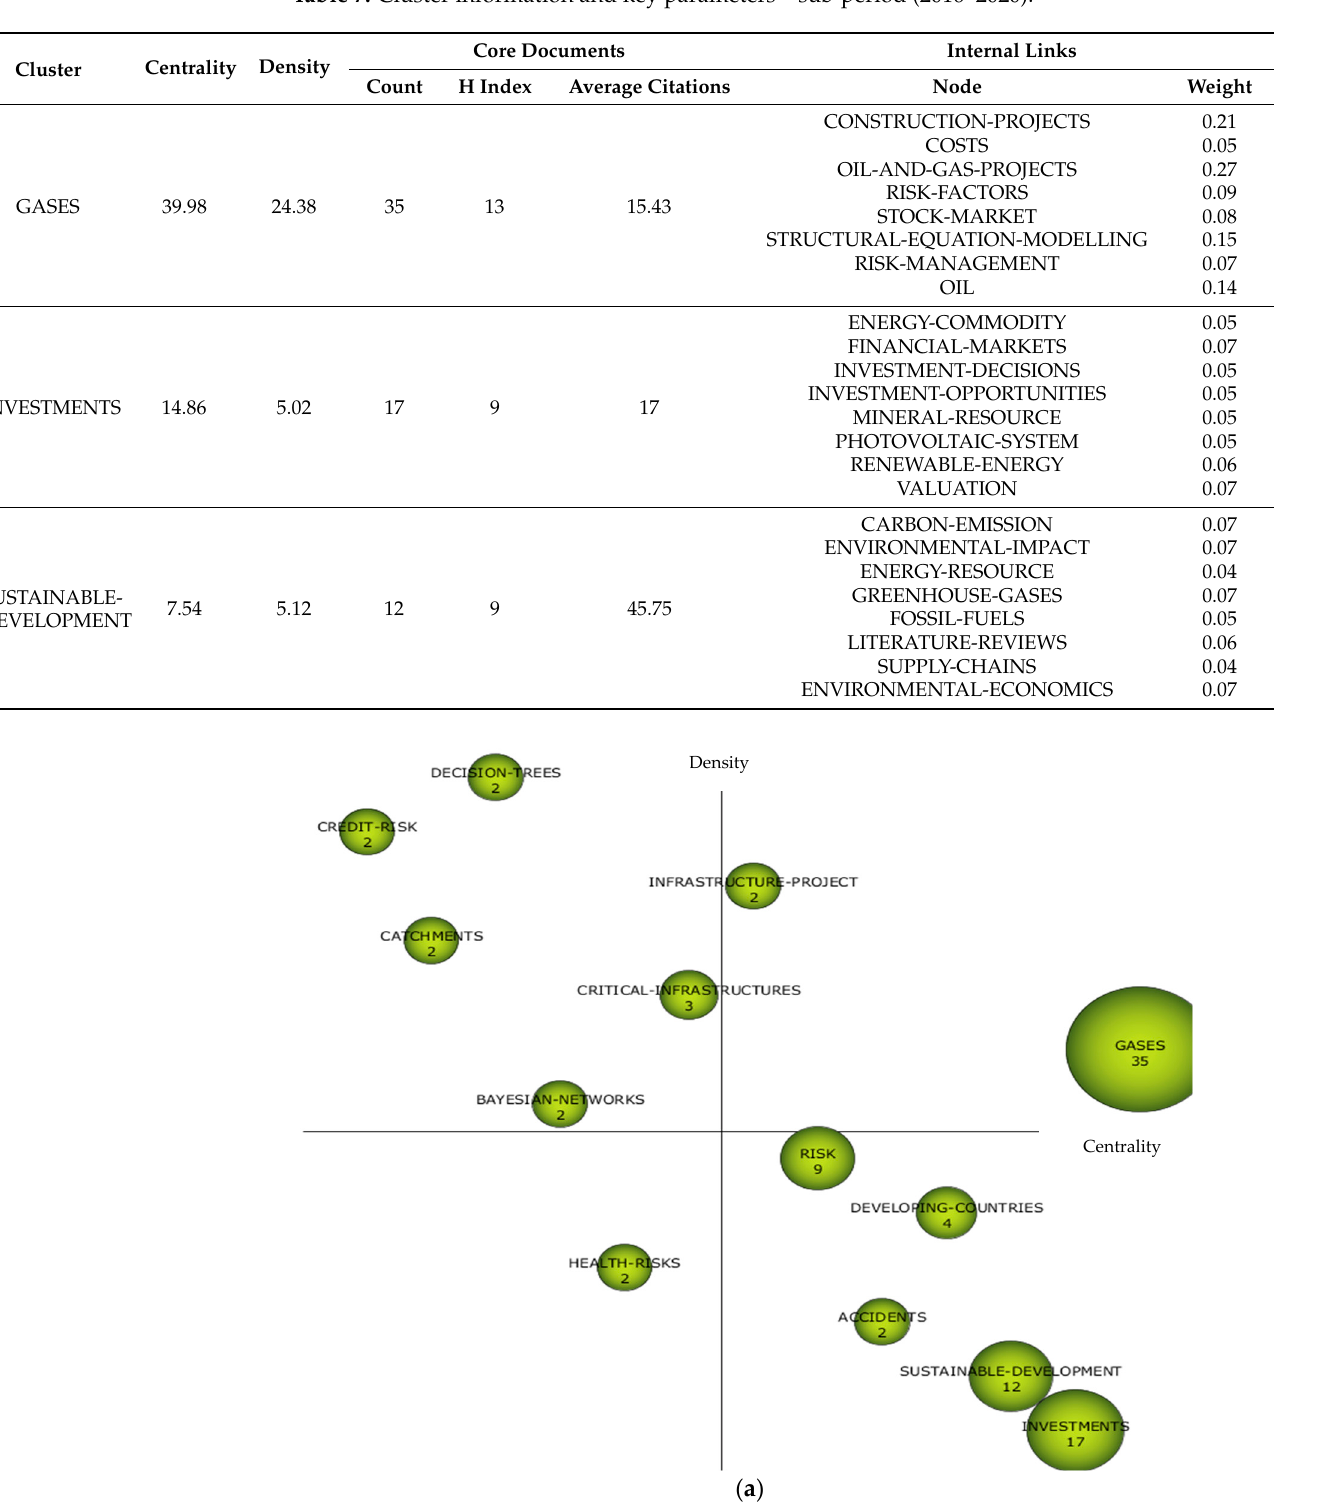
Table 7. Cluster information and key parameters—sub-period (2016–2020).